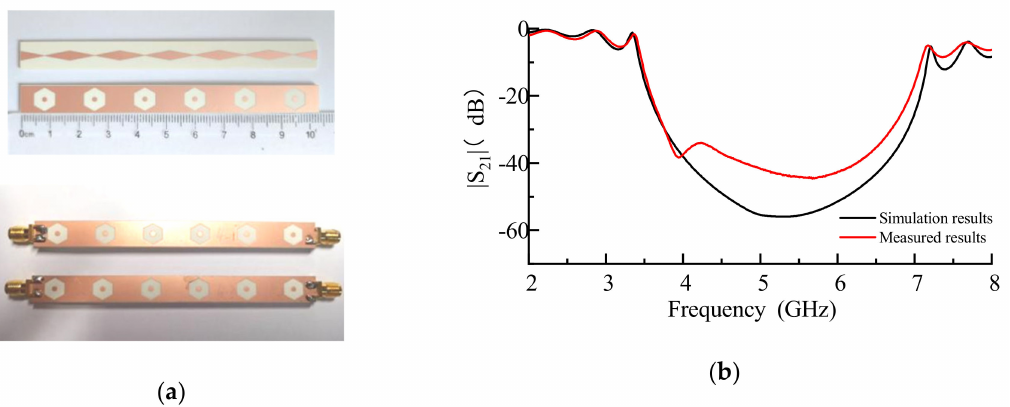
Figure 9. ( a ) Physical photographs of the microstrip band stop filter etched with periodic hexagon ring EBGs welding with an SMA joint; ( b ) comparison of the measured and simulated results of the filter etched with periodic hexagon ring